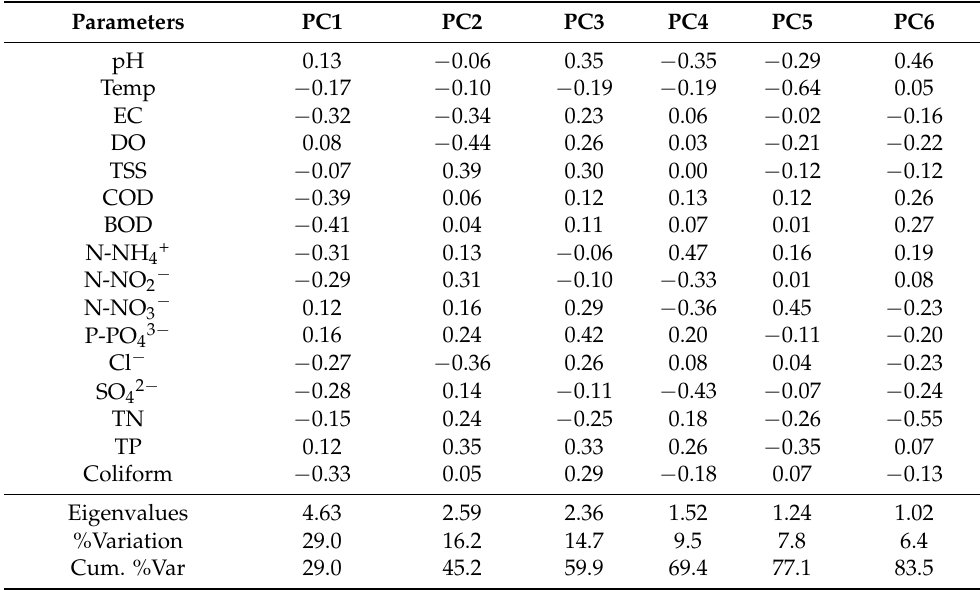
Table 3. Key parameters influencing water quality in Tien Giang Province in 2019.